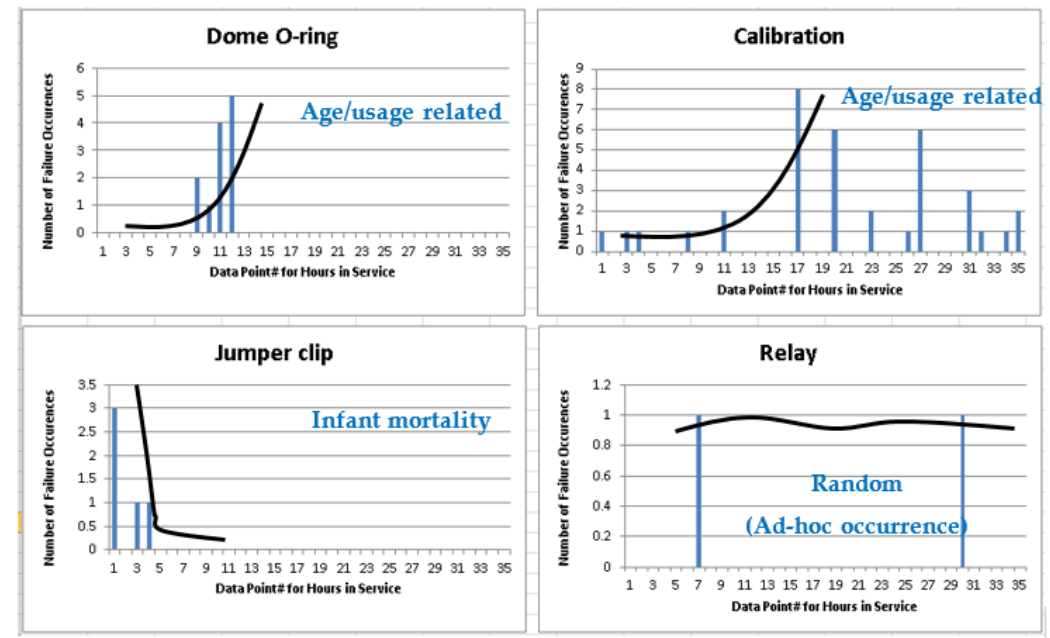
Figure 3. Measurement Instrument Individual Failure Mode Plots.